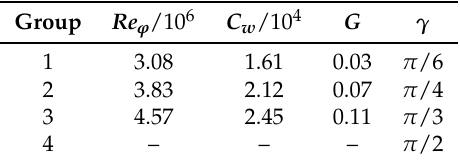
Table 2. Grouped variable parameters and their nominal values or factor levels.